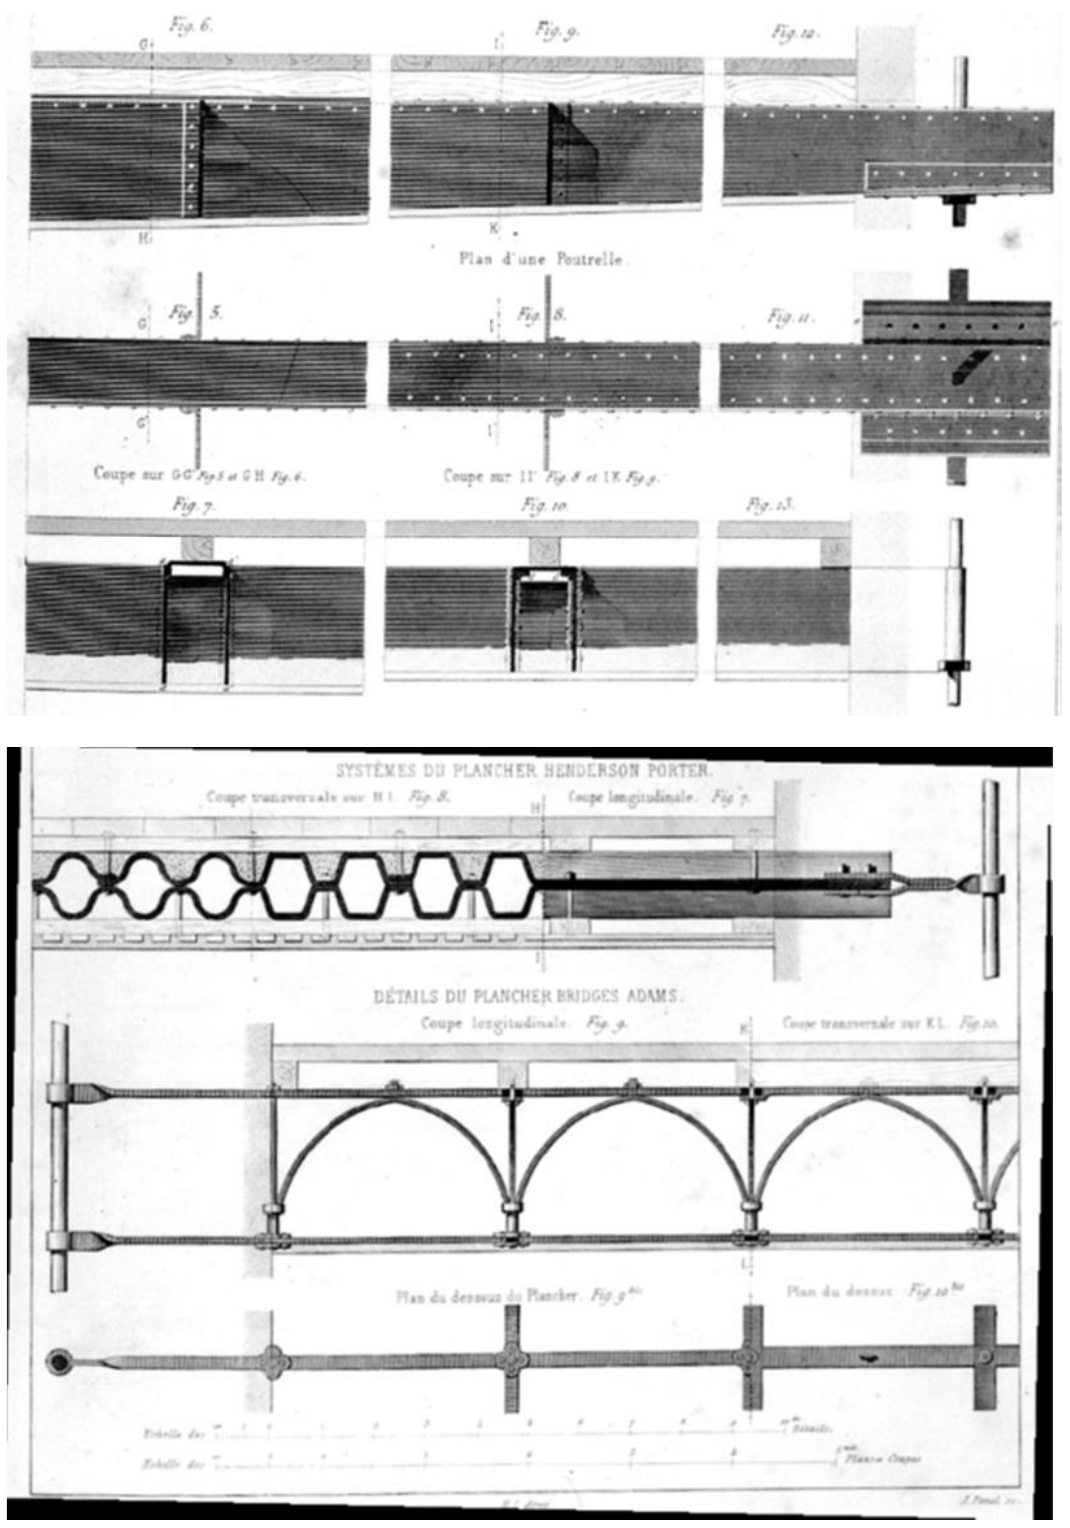
Figure 30. Different types of patents for lightweight metal slabs. Article signed by Sirodot in the “ Revue Générale de l ’ architecture et des Travaux Publics ” , 1853. From top to bottom: Bertrand Hus- son System, Coulaine and Joly-Leterme System and Henderson Porter and Bridges Adams System.